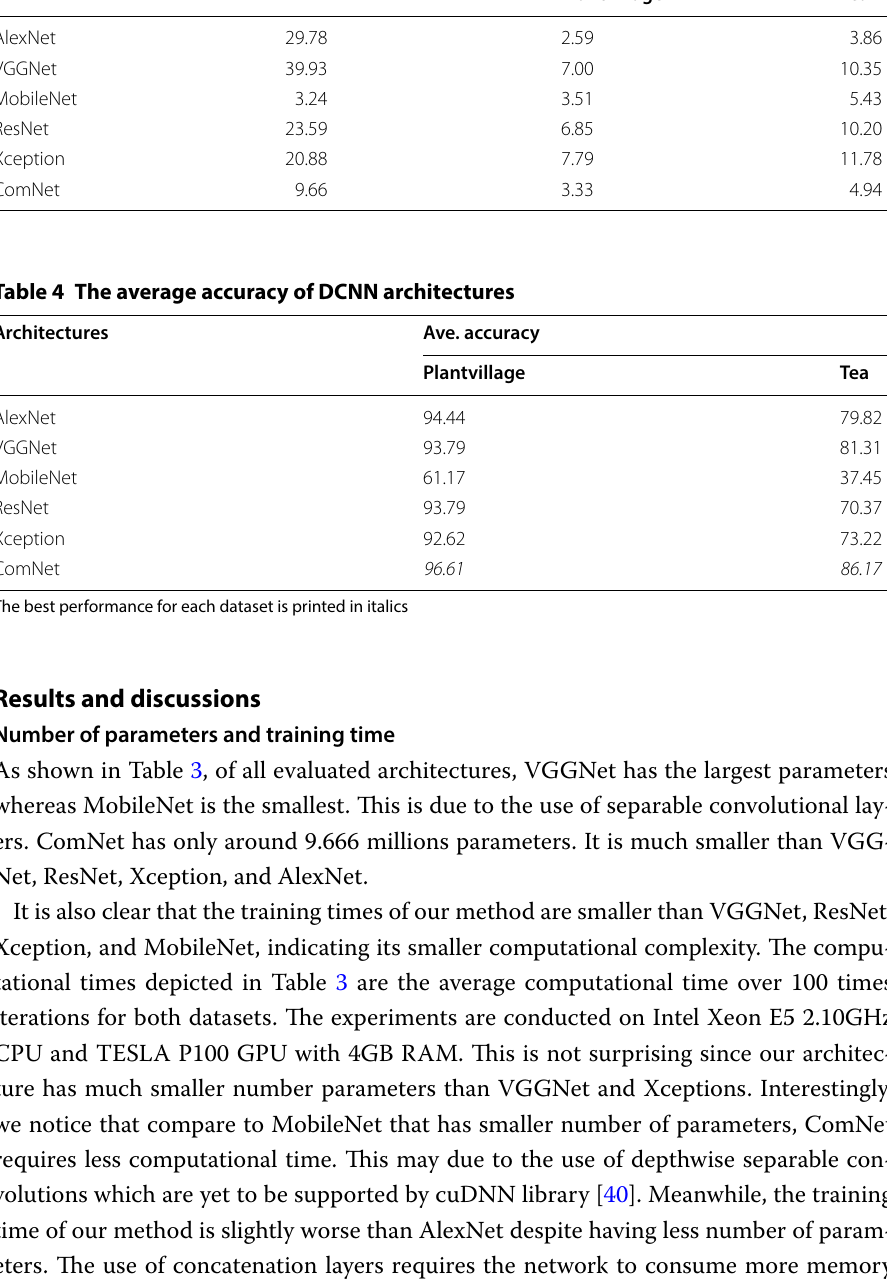
Table 3 The number of parameters (in millions) and the average training time (in seconds) of an epoch for each CNN architectures Architectures